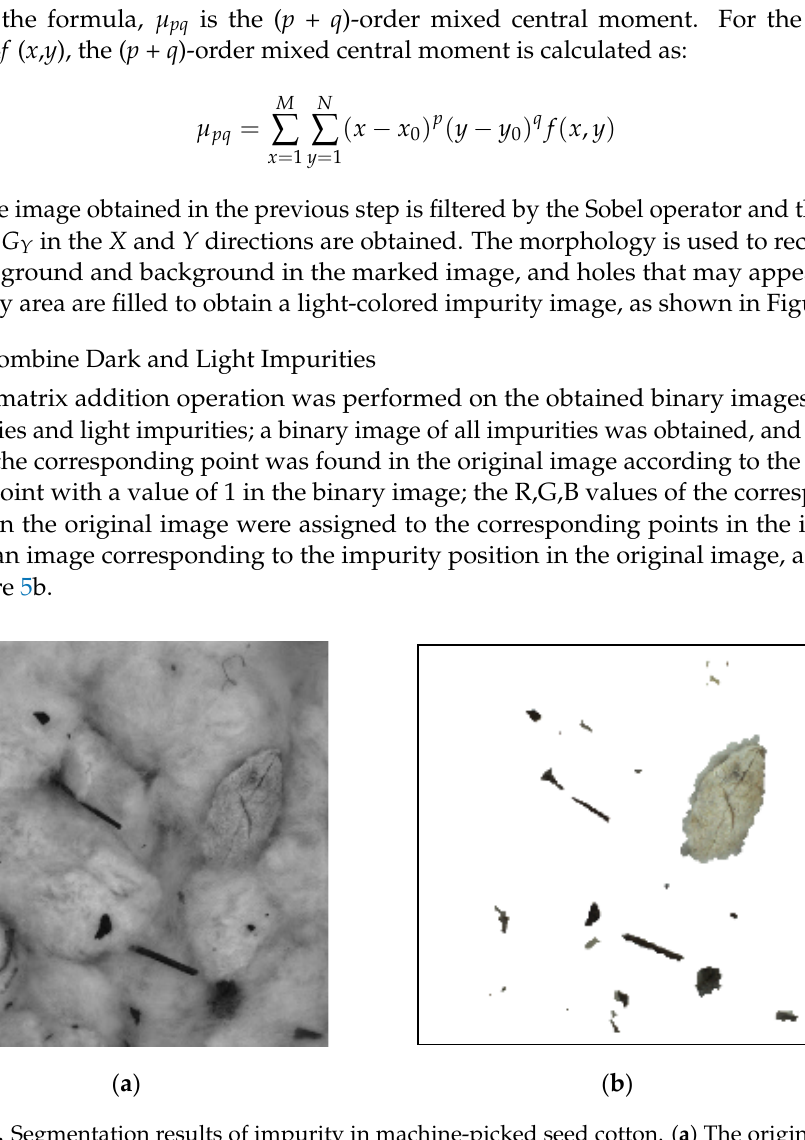
Figure 4. Segmentation of a light-color impurity image under the b channel. ( a ) The original image; ( b ) extracted b channel; ( c ) zone filling; ( d ) removal of small areas; ( e ) removal of the cotton back- ground; ( f ) hole filling.